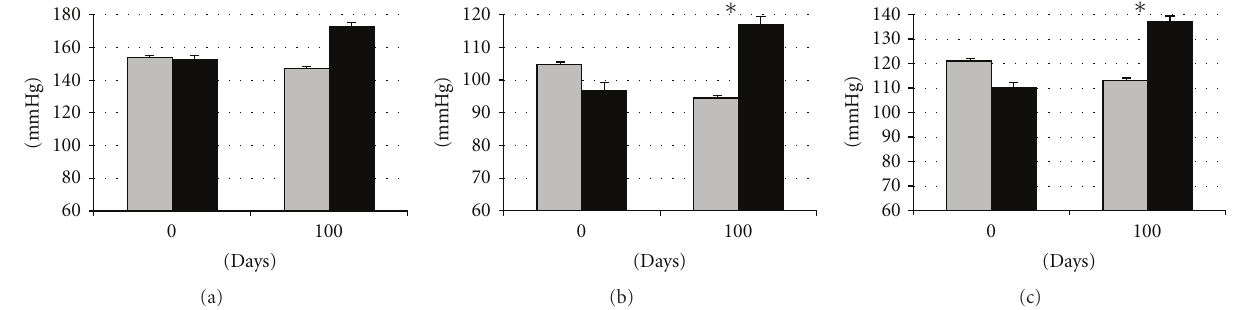
Figure 5: Changes in systolic (a), diastolic (b), and mean (c) blood pressures over time after di ff erential feeding in control sows (grey bars) and sows with ad libitum access to a diet enriched with saturated fat (black bars). Asterisks indicate significant di ff erences.